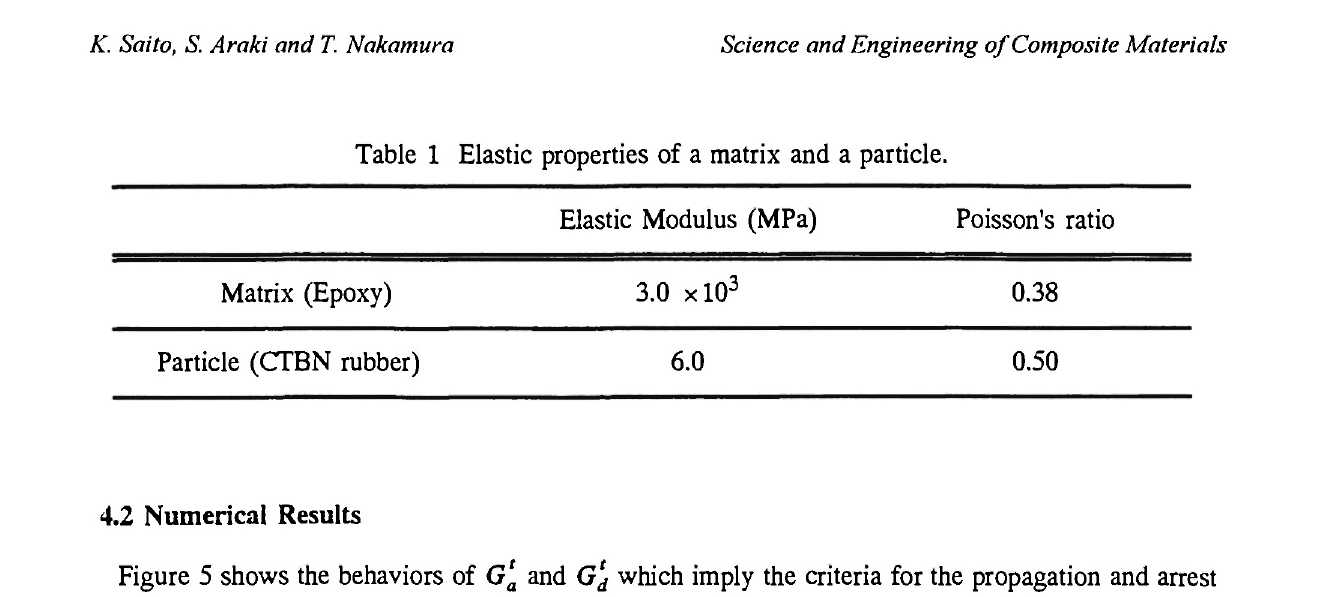
Table 1 Elastic properties of a matrix and a